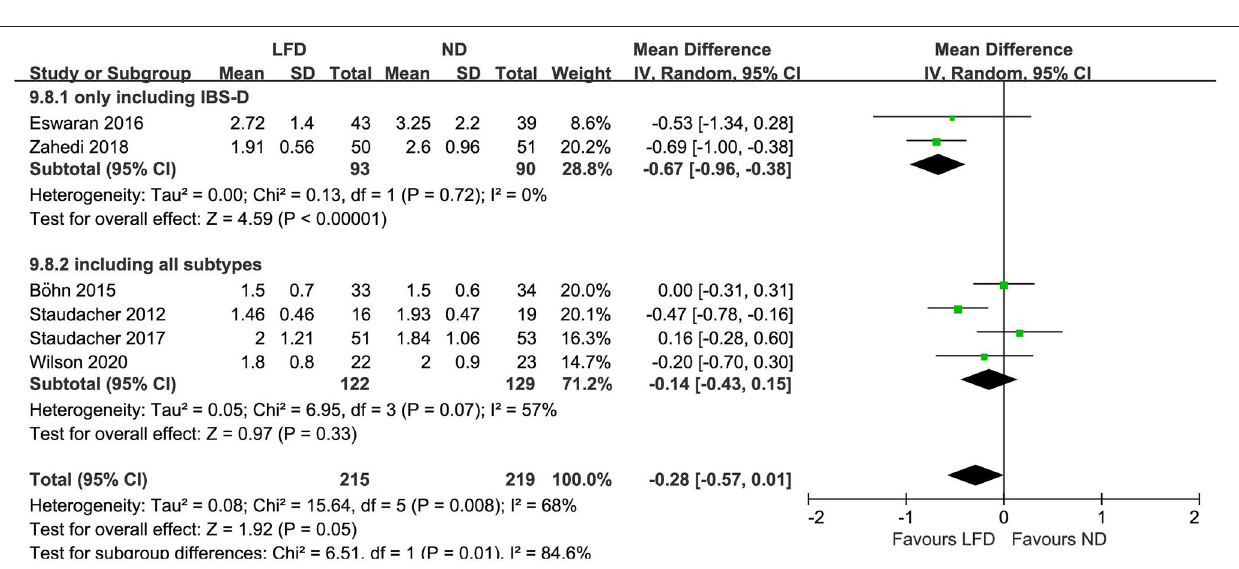
FIGURE 4 | Pooled mean difference for stool consistency based on the Bristol Stool Form Scale. LFD, low-FODMAP diet; ND, normal diet.